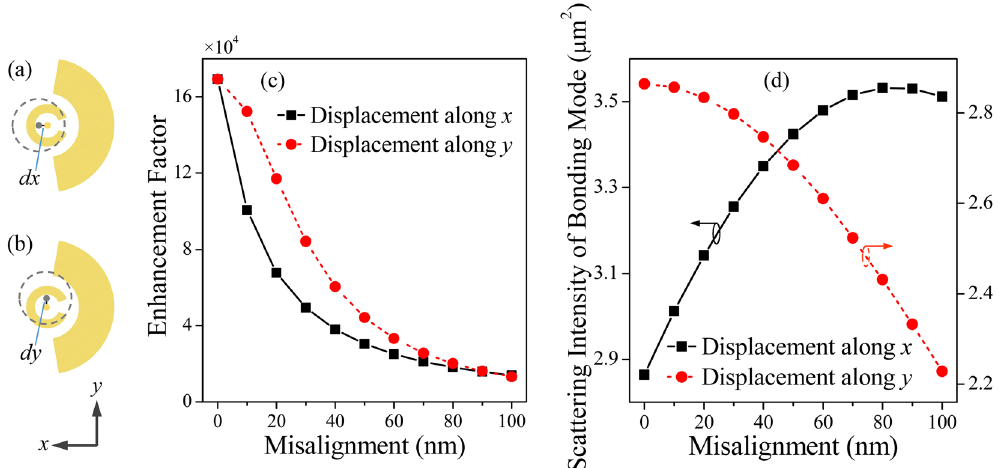
Figure 6. Schematic of the in-plane misalignment between APB and SRR-nanoarc structure along ( a ) x and ( b ) y directions, where the positions of APB are indicated by gray dashed circles. ( c ) EF and ( d ) scattering intensity of bonding mode versus the displacements of APB along x (black rectangles) and y (red dots)